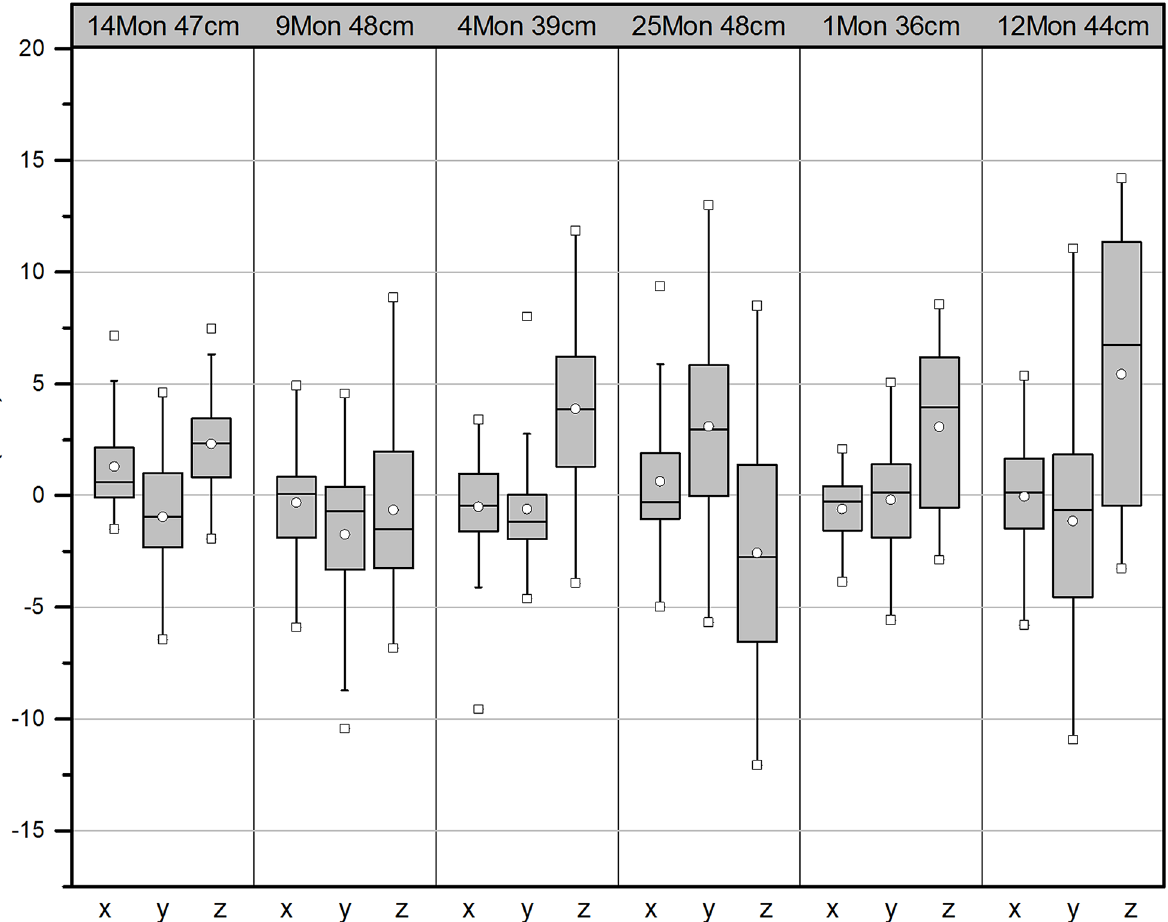
Fig 4. Box plots of signed error in mm between predicted landmark coordinates and the actual landmarks collected from CT data of sampled six subjects. Top row represents the age in month and the head circumference in cm of the